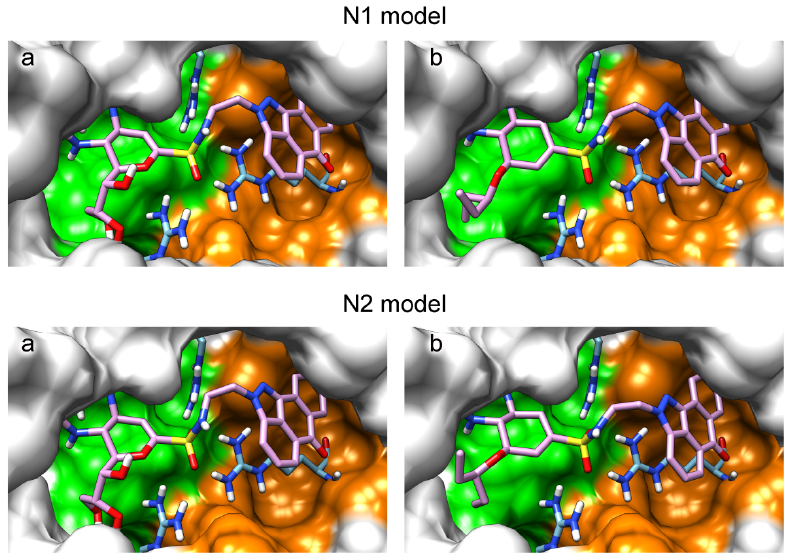
Figure 5. Positions of prototype bifunctional inhibitors based on zanamivir ( a ) and oseltamivir ( b ) in N1 and N2 neuraminidase models. The sulfonamide linker provides the effective interaction with the arginine triad.